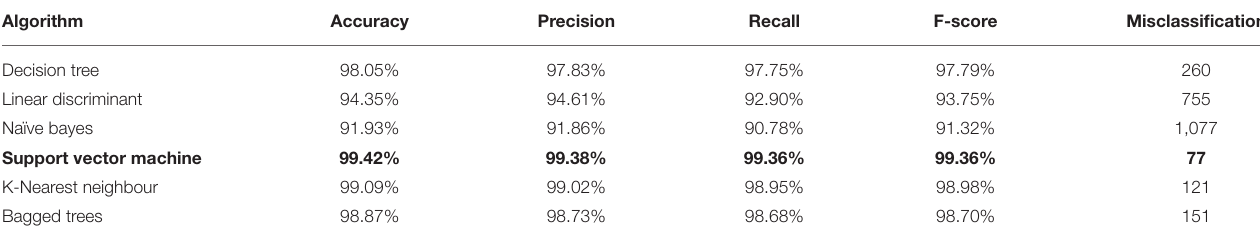
TABLE 10 | Preventive maintenance performance evaluation.